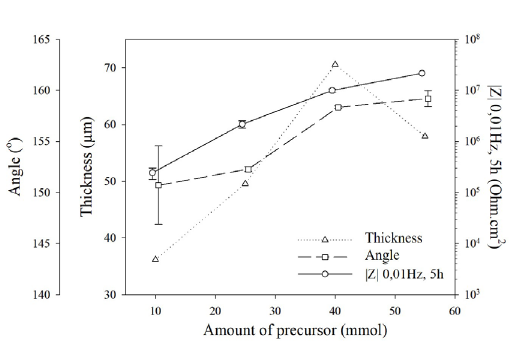
Figure 8. Response profiles as a function of the amount of silane precursor for water contact angle, film thickness, and impedance modulus at 0,01 Hz after 5 hours of immersion in NaCl